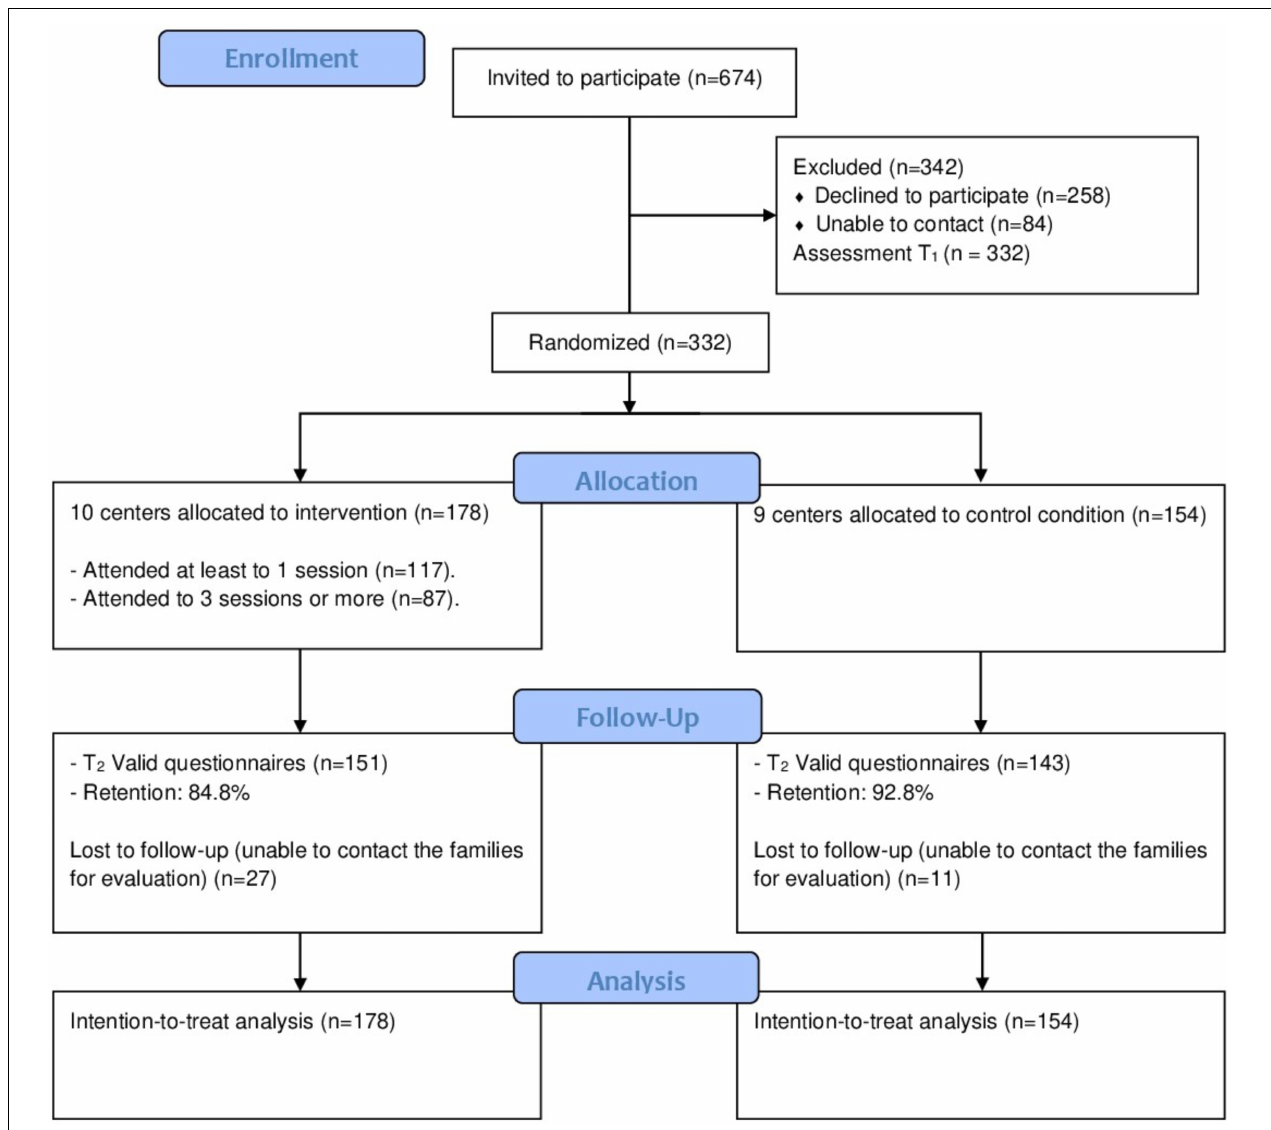
FIGURE 1 | Participants flow